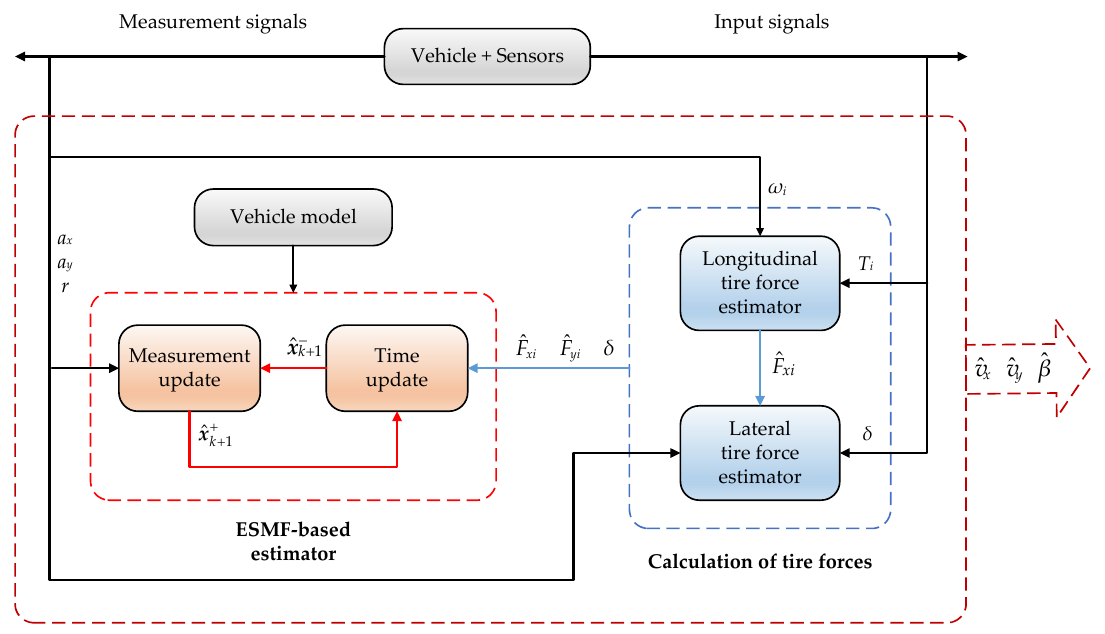
Figure 2. Block diagram of robust estimation